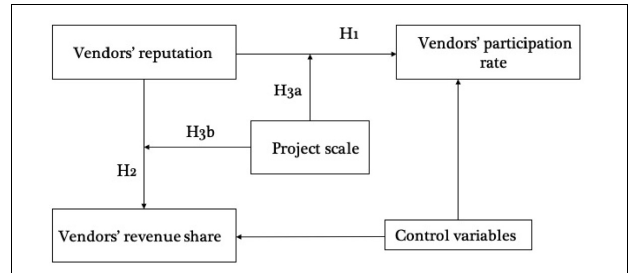
FIGURE 1 | Research